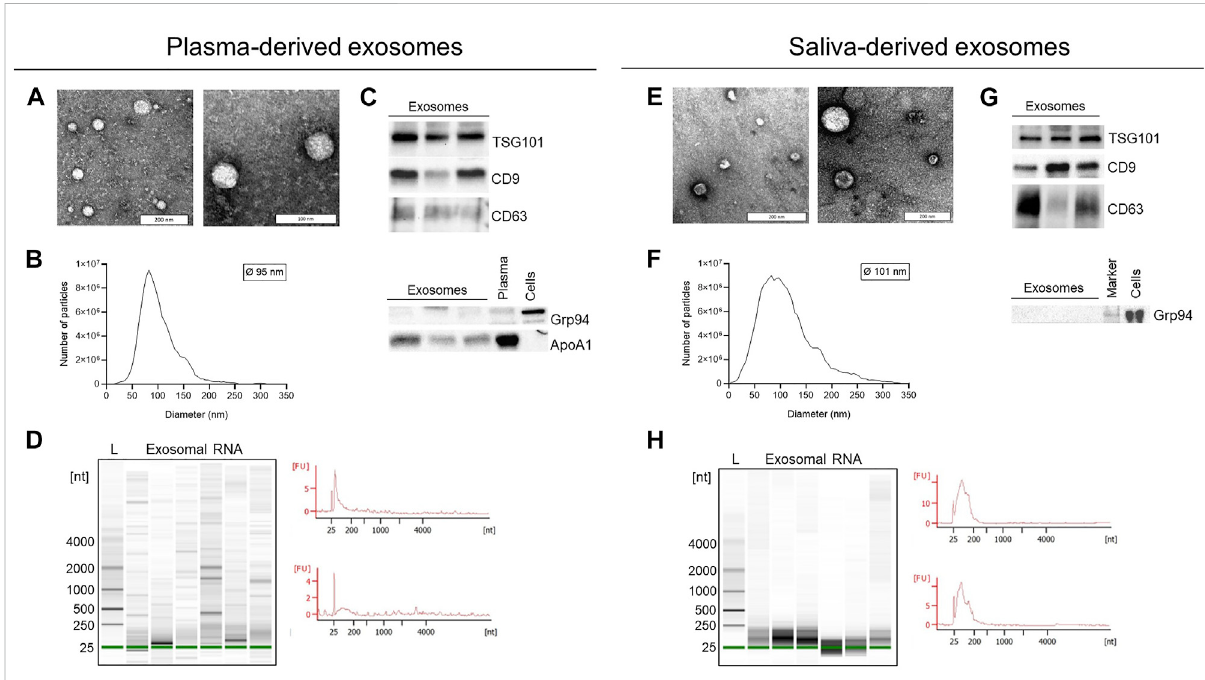
FIGURE 2 Characterization of exosomes and exosomal RNA isolated from plasma and saliva. (A,E) Representative transmission electron microscopy images of exosomes isolated from plasma (A) or saliva (E) by ultracentrifugation. (B,F) Representative size distribution histogram and mean diameter of plasma- (B) and saliva- (F) derived exosomes analyzed by nanoparticle tracking analysis (NTA). (C,G) Western blot analysis of exosomes isolated from plasma (C) or saliva (G) . Exosomal markers TSG101, CD9, and CD63 were present and the negative marker Grp94 was absent in all preparations. Exosomes from plasma carry low amounts of ApoA1. Plasma and cell lysates were used as positive control for ApoA1 and Grp94. (D,H) RepresentativeAgilentbioanalyzergelimagesandelectropherogramsoftotalexosomalRNAisolatedfromplasma (D) orsaliva (H) andanalyzedwith the Pico Chip. L, ladder/size marker: Nt, nucleotides: FU, arbitrary fl uorescent